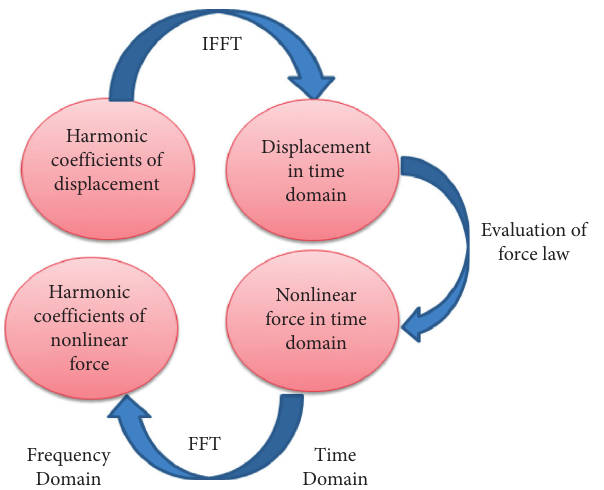
Figure 1: AFT description to calculate the nonlinear force